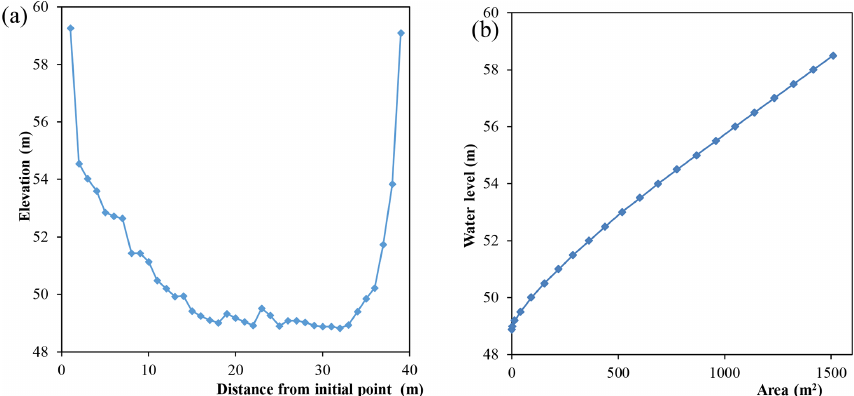
Figure 6. Diagram of analysis results of relationship between water level and flow at Shitai station.